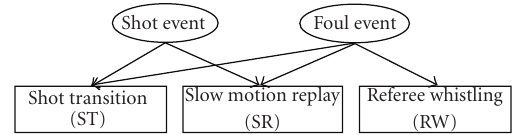
Figure 3: Naive Bayesian network for shot and foul events